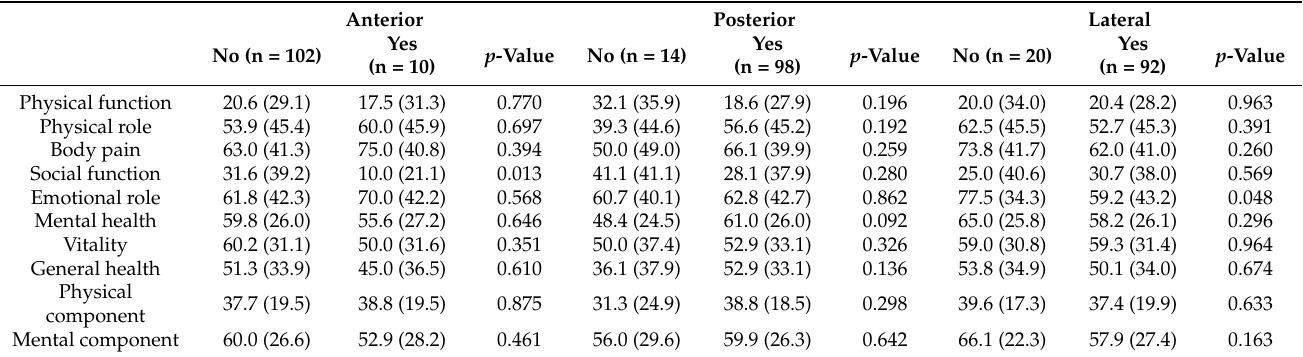
Table 4. Dimensions and components of SF-12 among women with affected compartment of deep